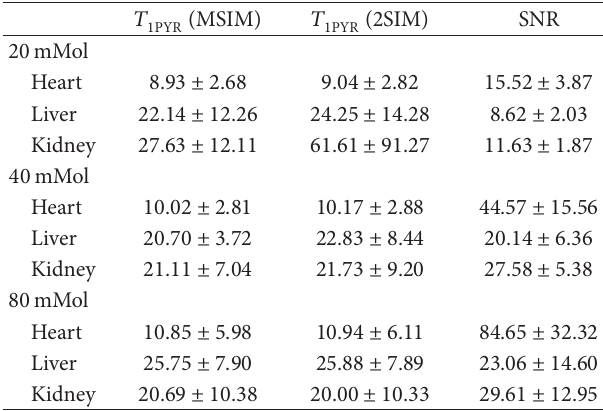
Table 2: 𝑇 1 calculated for MSIM and 2SIM and corresponding pyr SNR levels for all concentrations and slices (mean ± standard deviation).